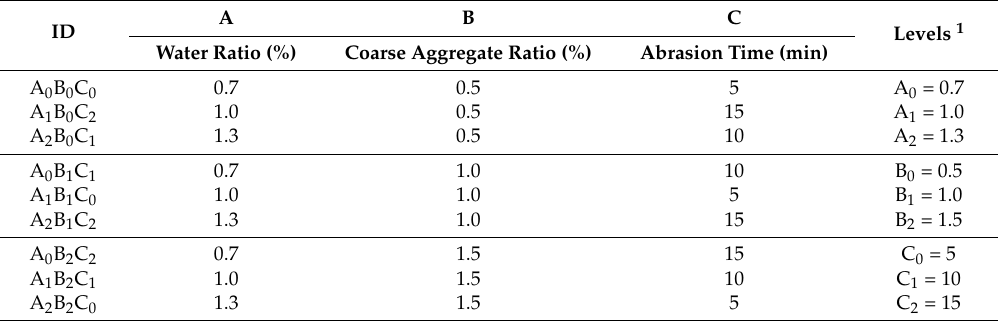
Table 2. The level of experiment.